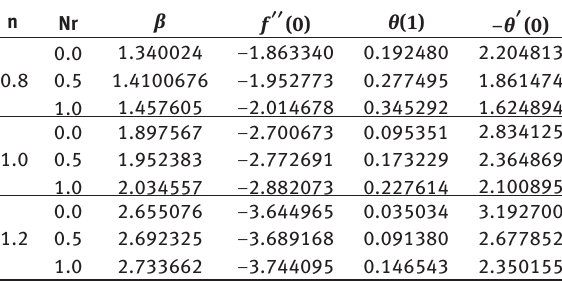
Table 6: Values for β , f (cid:2)(cid:2) (0) , θ (1) and − θ